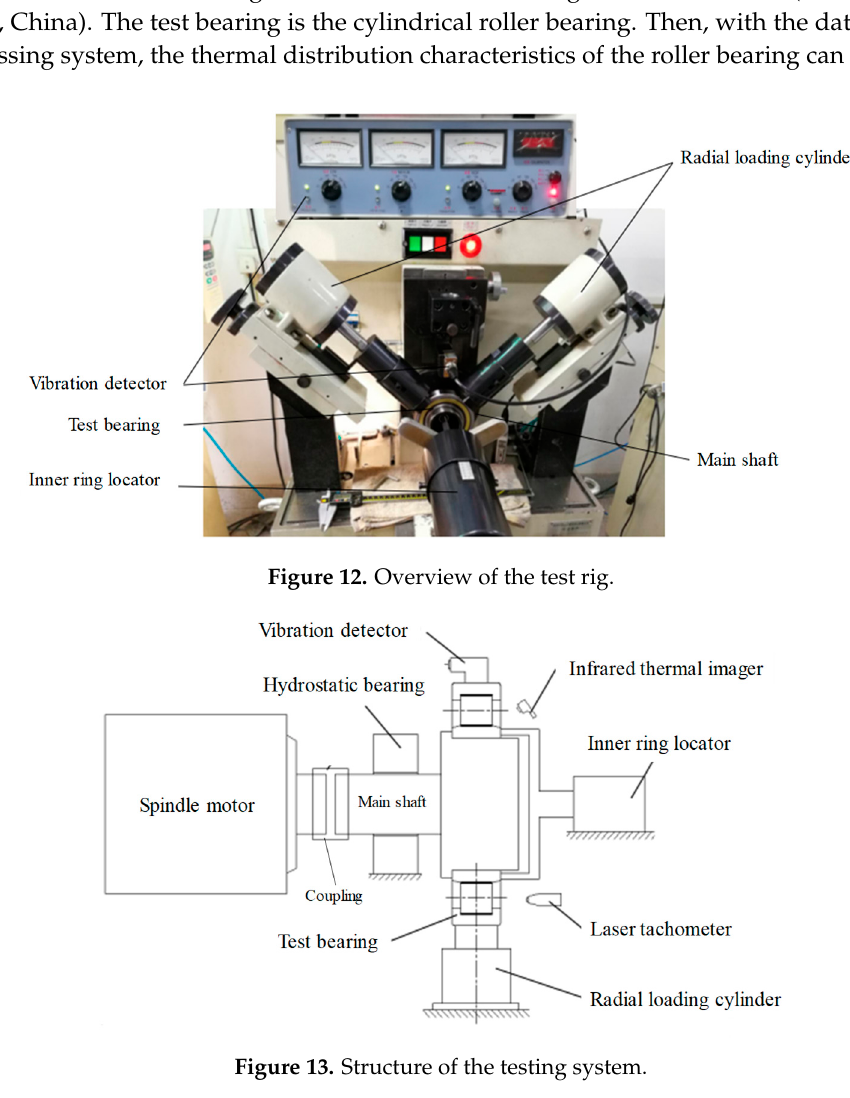
Figure 13. Structure of the testing system.